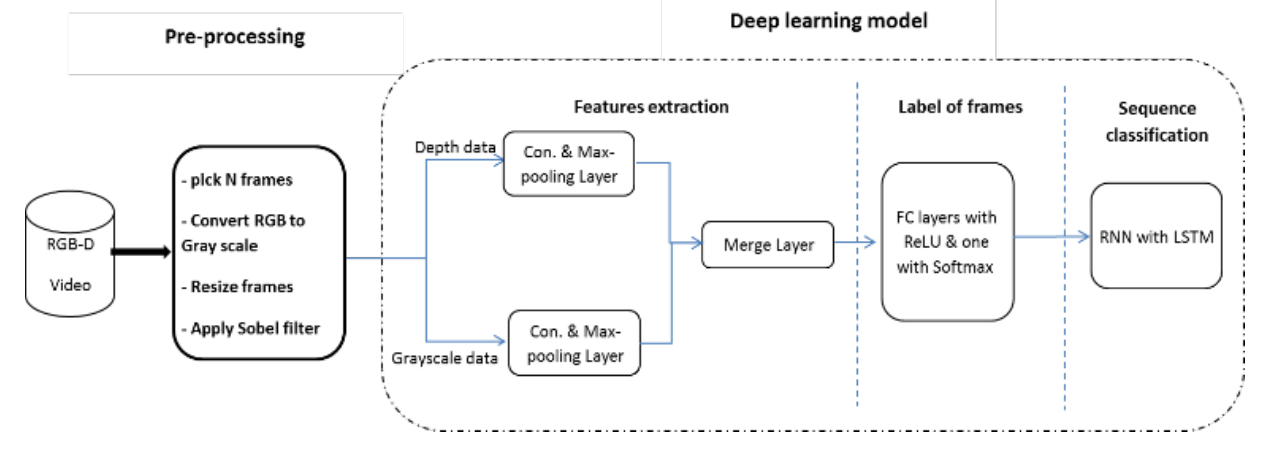
Fig. 1. The framework of the